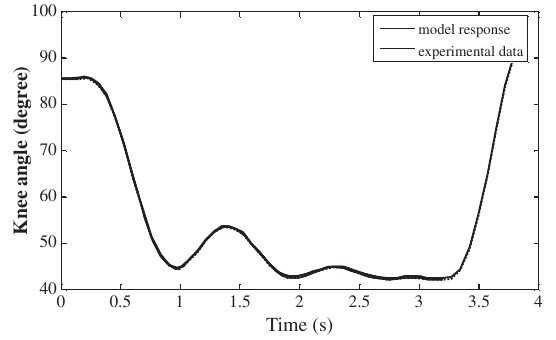
Fig. 10. The experimentally measured and simulated knee